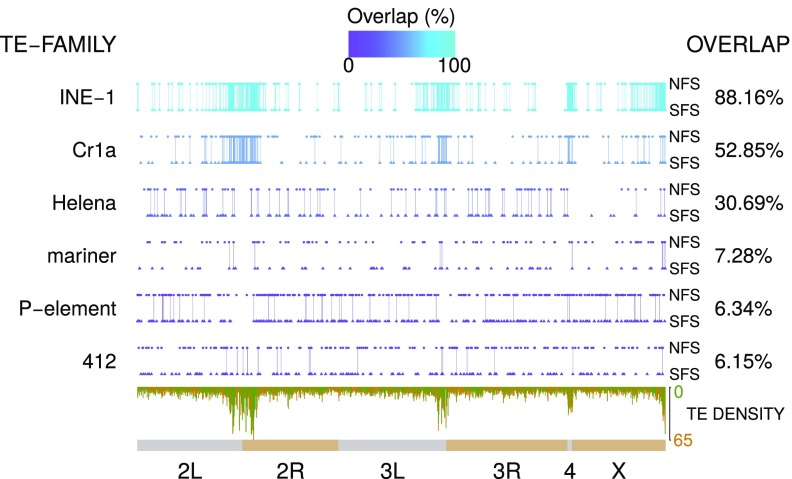
Examples of TE distributions along chromosomal arms: INE-1, Cr1a, Helena, mariner, P-element, and 412. Each round dot represents one NFS insertion, and each triangle represents one SFS insertion. Connection lines between dots indicate sharing of same insertions. The color of the line for each TE family reflects the overlap percentage between NFS and SFS, from low (dark color, purple) to high (bright color, cyan). TE densities (green for NFS and orange for SFS) were calculated based on a 100-kb window.